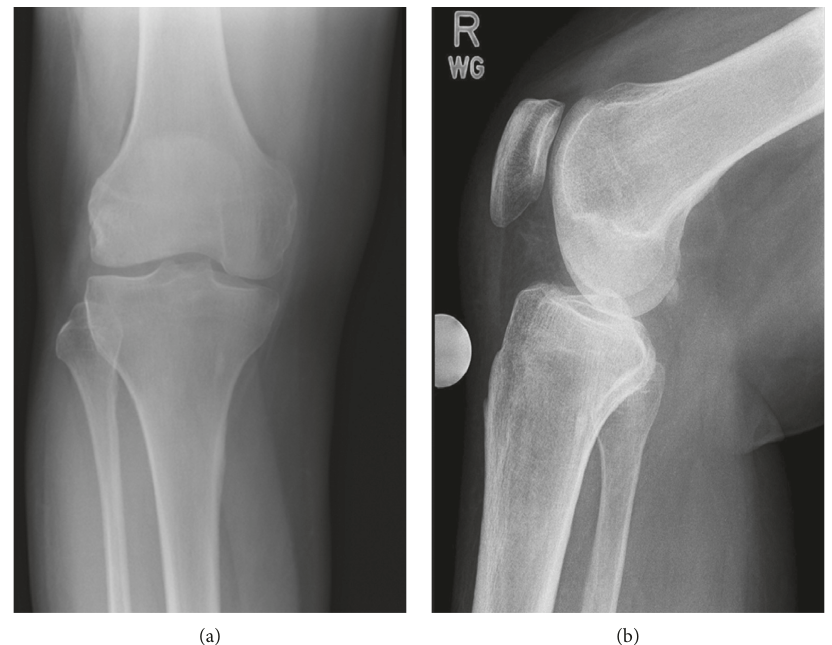
Figure 1: Initial (a) AP radiograph of the knee and (b) Lateral radiograph of the knee were normal.